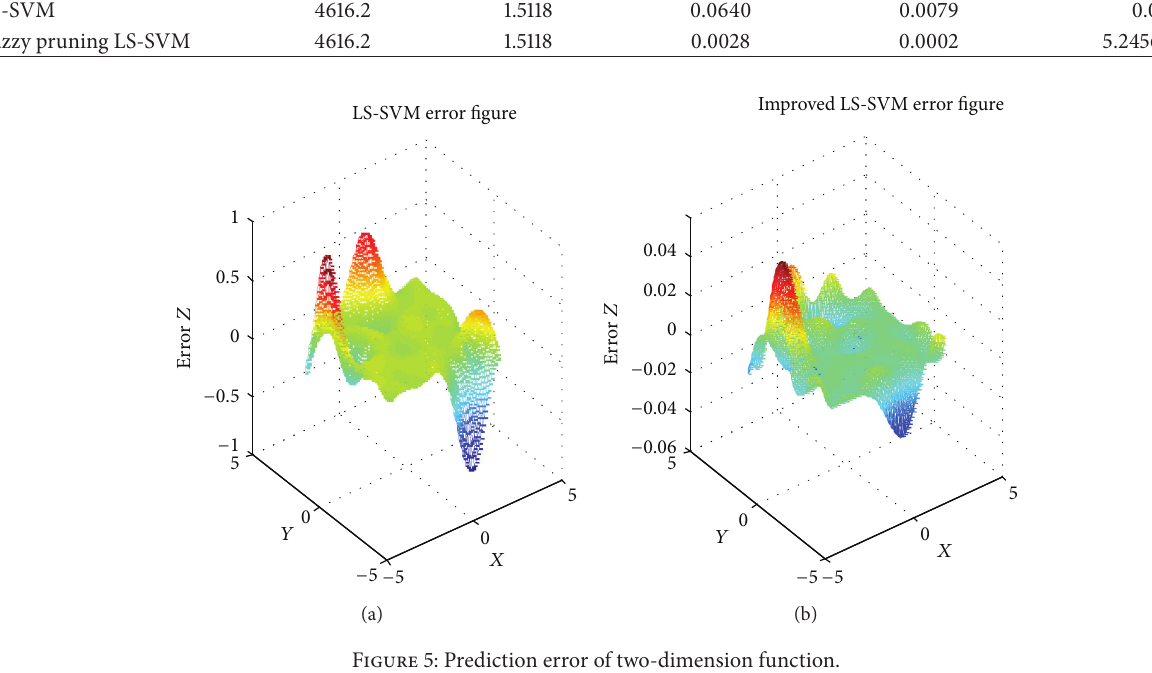
Figure 5: Prediction error of two-dimension function.